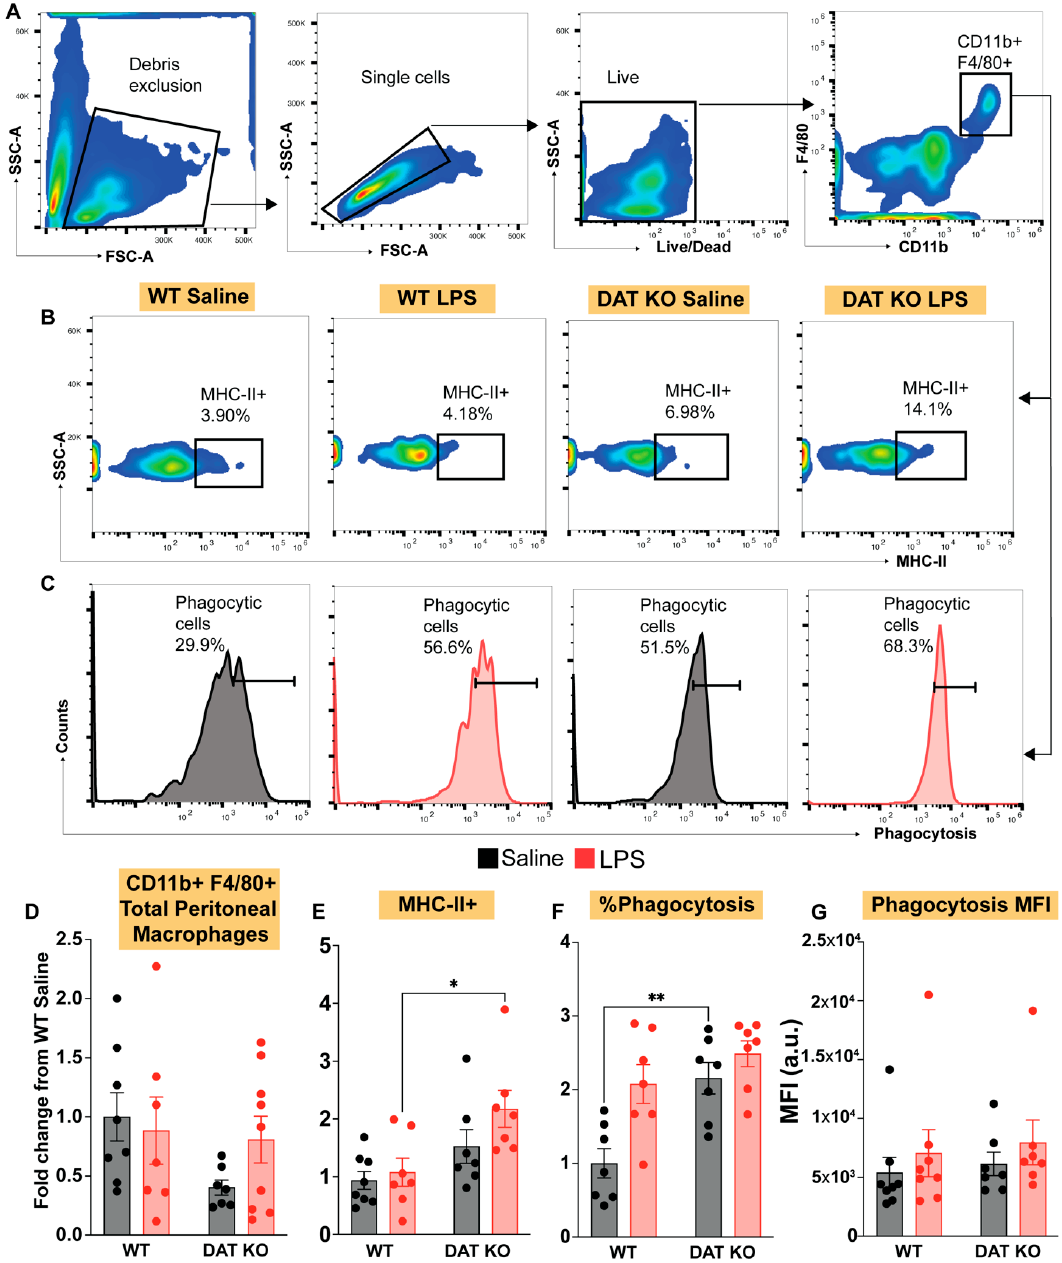
Figure 4. Peritoneal macrophages from DAT − / − animals exhibit increased MHC-II expression and exaggerated phagocytic response. ( A – C ) Peritoneal macrophages were harvested and stained for macrophage markers F4/80 and CD11b, MHC-II and assessed for phagocytic capacity. Following LPS-induced immune stimulation, DAT − / − animals exhibit no change in total peritoneal macrophages ( D ) but showed increased MHC-II expression in response to LPS, as compared to WT littermate controls ( B , E ). In line with this finding, investigation of phagocytic response to LPS revealed that DAT − / − animals exhibit an exaggerated number of phagocytosing cells both at baseline and following LPS stimulation ( C , F ), but with no change in the amount phagocytosed per cell ( G ), indicating a dysregulated response to immune stimulation in the absence of DAT. (Two ANOVA with Sidak’s correction for multiple comparisons; n = 6–9 per group. * p < 0.05, ** p < 0.01).